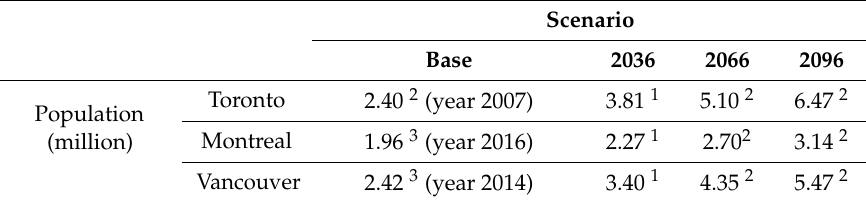
Table 7. The projected population for Toronto, Montreal, and Vancouver scenarios 2036, 2066, and 2096